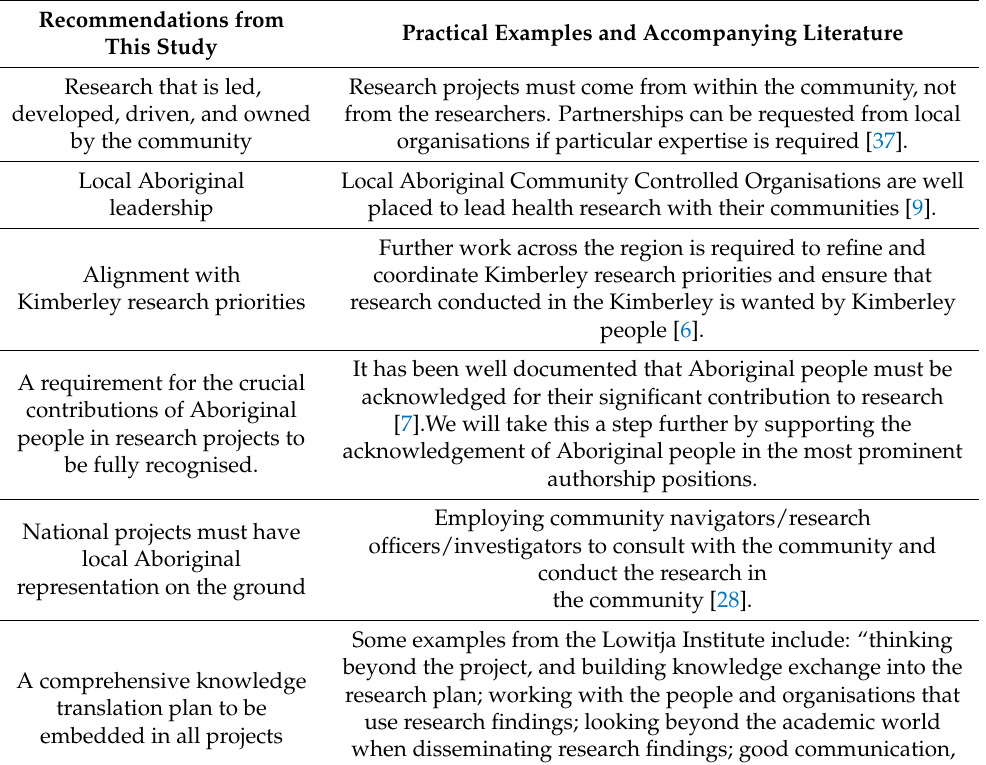
Table 4. Recommendations for a Kimberley Aboriginal health research